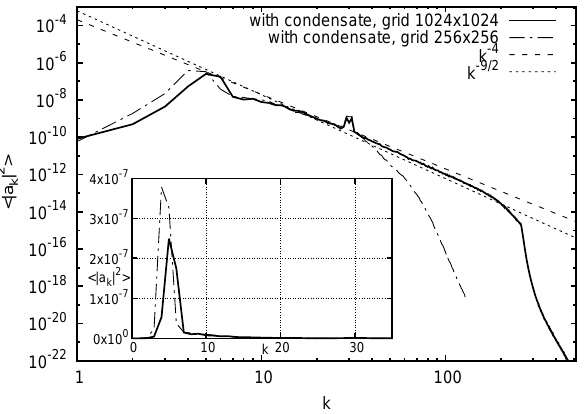
Figure 15. Angle-averaged spectrum with the condensate. Two grid sizes. Slopes for the KZ spectrum and Phillips spectrum are shown for a reference by dashed and dotted lines respectively. Main figure: logarithmic scale; inset: linear scale.